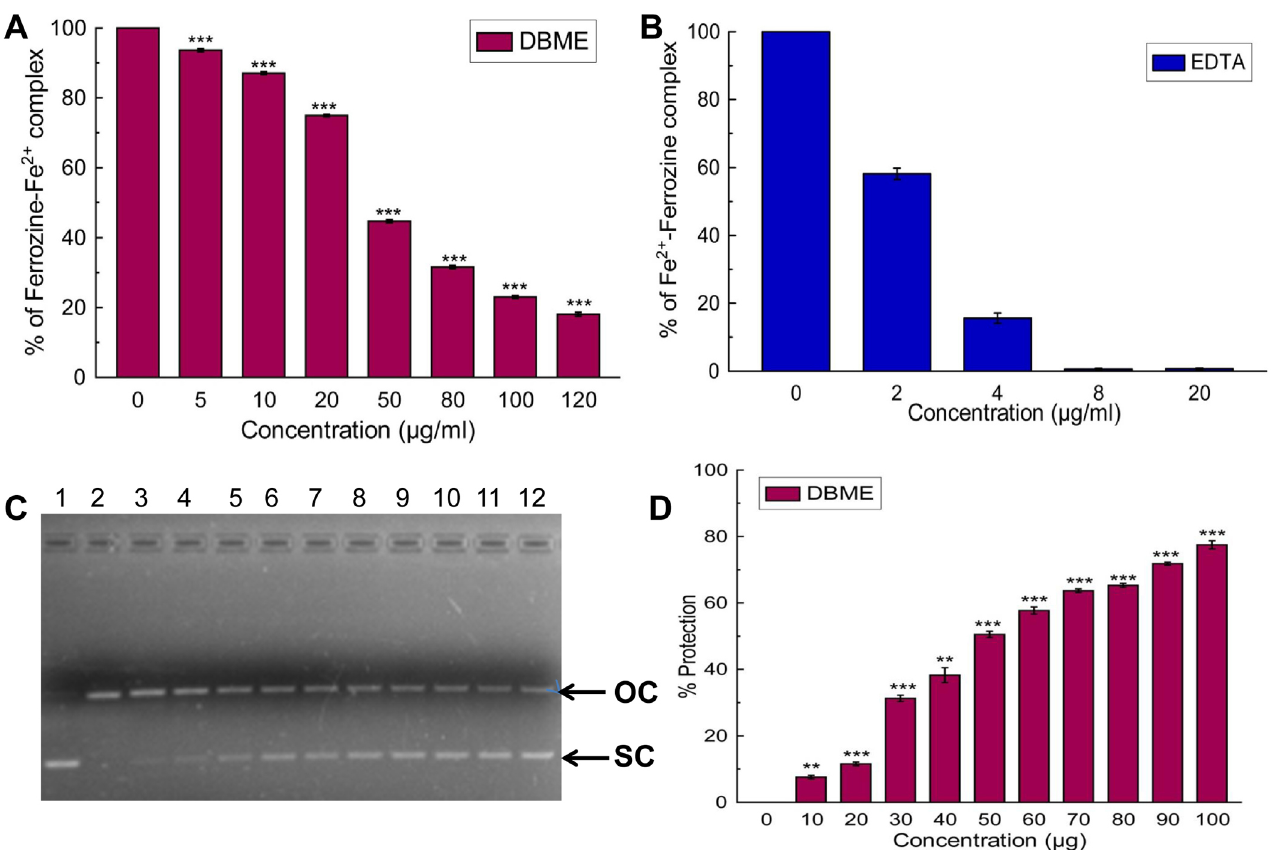
Fig 4. Iron chelation activity of DBME. (A) In vitro iron chelation acitivity of DBME. (B) In vitro iron chelation activity of EDTA. (C) Picture of agarose gel of pUC-18 DNA showing bands of supercoiled (SC) and open circular (OC) forms. Lanes on the gel represent: (Lane 1) control DNA (no H 2 O 2 or Fe 2+ ); (Lane 2) reaction mixture without extract; (Lane 3 – 12) reaction mixtures with extract of increasing concentrations (10 – 100 μ g) (D) Graphical representation of % of supercoiled DNA protection by DBME. The results are mean ± S.D. of six parallel measurements. ** p < 0.01 and *** p < 0.001 vs 0 μ g/ml.